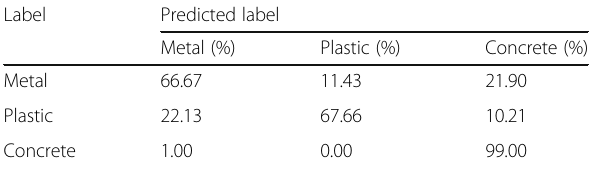
Table 4 Confusion matrix of the IAMF